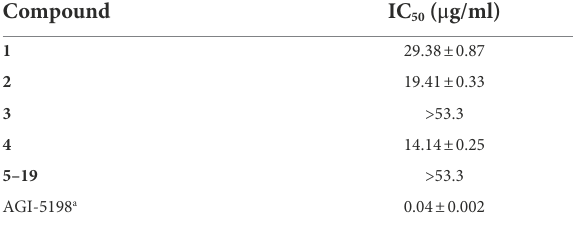
TABLE 4 Inhibitory activities of compounds against IDH1-R132H.